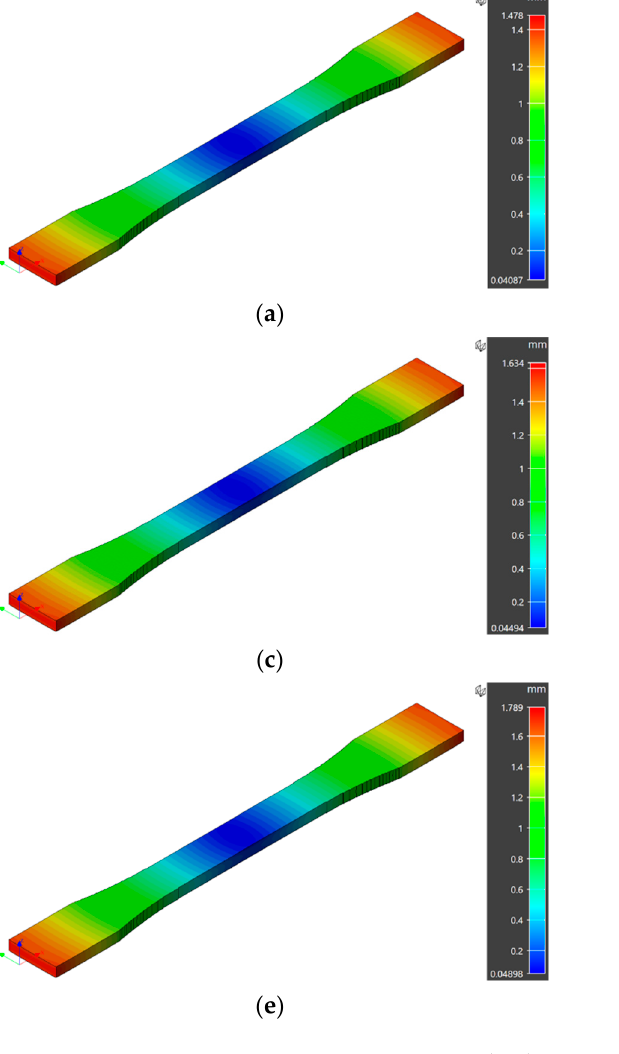
Figure 2. Maximum Displacements in Numerical Model Simulations at Different Extrusion Tem- Figure 2. Maximum displacements in numerical model simulations at different extrusion tempera- peratures ( a ) 210 °C ( b ) 220 °C ( c ) 230 °C ( d ) 240 °C ( e ) 250 °C ( f ) 260 °C. tures: ( a ) 210 ◦ C, ( b ) 220 ◦ C, ( c ) 230 ◦ C, ( d ) 240 ◦ C, ( e ) 250 ◦ C, ( f ) 260 ◦